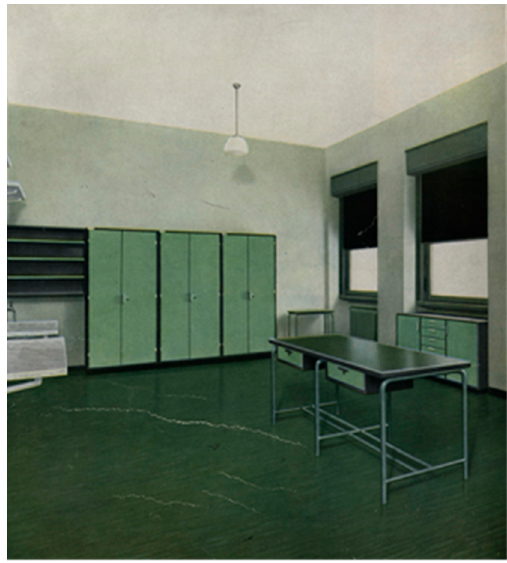
Figure 39. The Superior and Experimental Physics graduated classroom. Photo from (De Smaele 1936, p. 21).